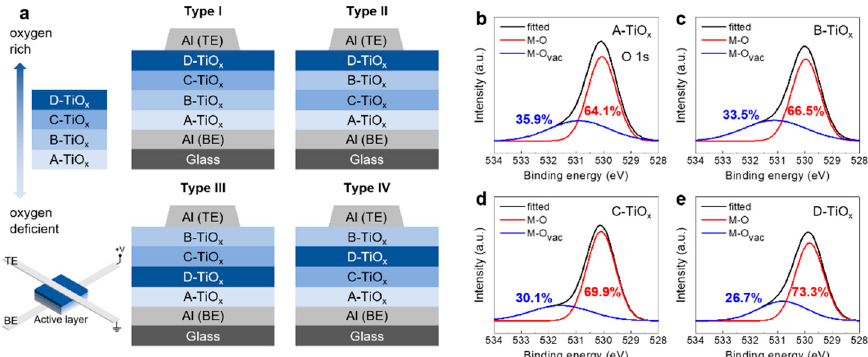
Figure 1. ( a ) Schematic device structures of the memristors having four TiO x sub-layers with different oxygen vacancy (O vac ) contents. The stacking sequence of the TiO x sub-layers was varied (types I, II, III, and IV). The thicknesses of the A-TiO x , B-TiO x , C-TiO x , and D-TiO x films were approximately 14.0 nm, 11.5 nm, 11.5 nm, and 9.0 nm, respectively. The O1s spectra measured by using the X-ray photoelectron spectroscopy (XPS) for, ( b ) A-TiO x , ( c ) B-TiO x , ( d ) C-TiO x , and ( e ) D-TiO x films.